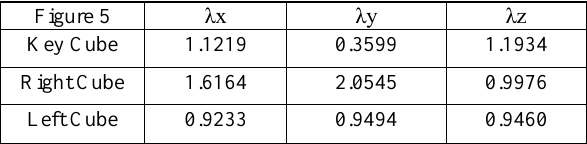
Table 2. Ground truth layout and created layout scale ratios.